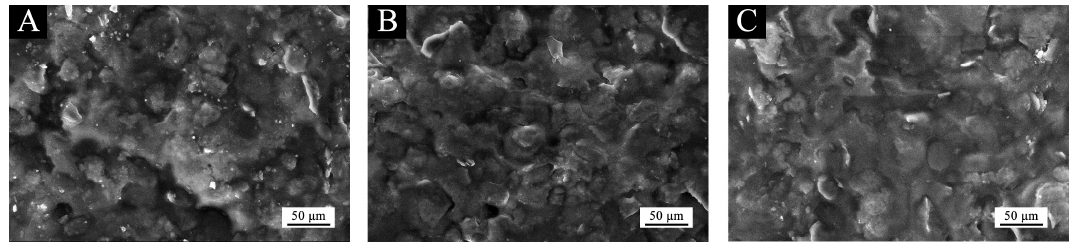
Figure 6. SEM of coating with Al powder: ( A ) 20.0%, ( B ) 25.0% and ( C ) 30.0%.